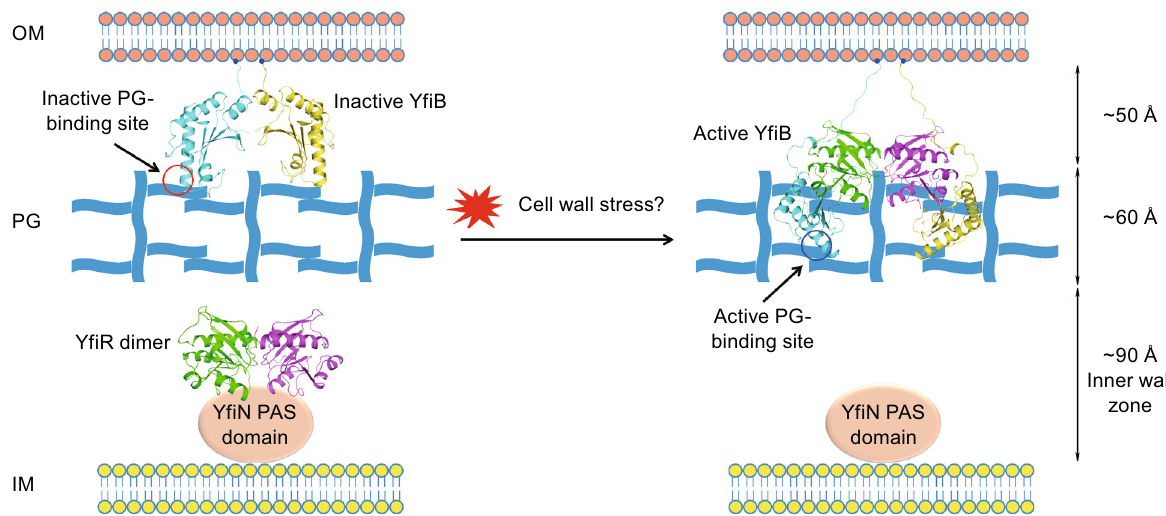
Figure 7. Regulatory model of the Y fi BNR tripartite system. The periplasmic domain of Y fi B and the Y fi B-Y fi R complex are depicted according to the crystal structures. The lipid acceptor Cys26 is indicated as blue ball. The loop connecting Cys26 and Gly34 of Y fi B is modeled. The PAS domain of Y fi N is shown as pink oval. Once activated by certain cell stress, the dimeric Y fi B transforms from a compact conformation to a stretched conformation, allowing the periplasmic domain of the membrane-anchored Y fi B to penetrate the cell wall and sequester the Y fi R dimer, thus relieving the repression of Y fi